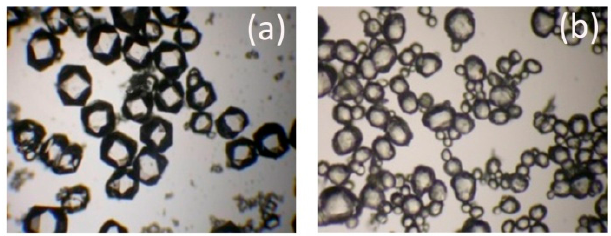
Figure 5. The microscopic photos of RDX samples after recrystallization ( a ); recrystallization and spheroidization ( b ).